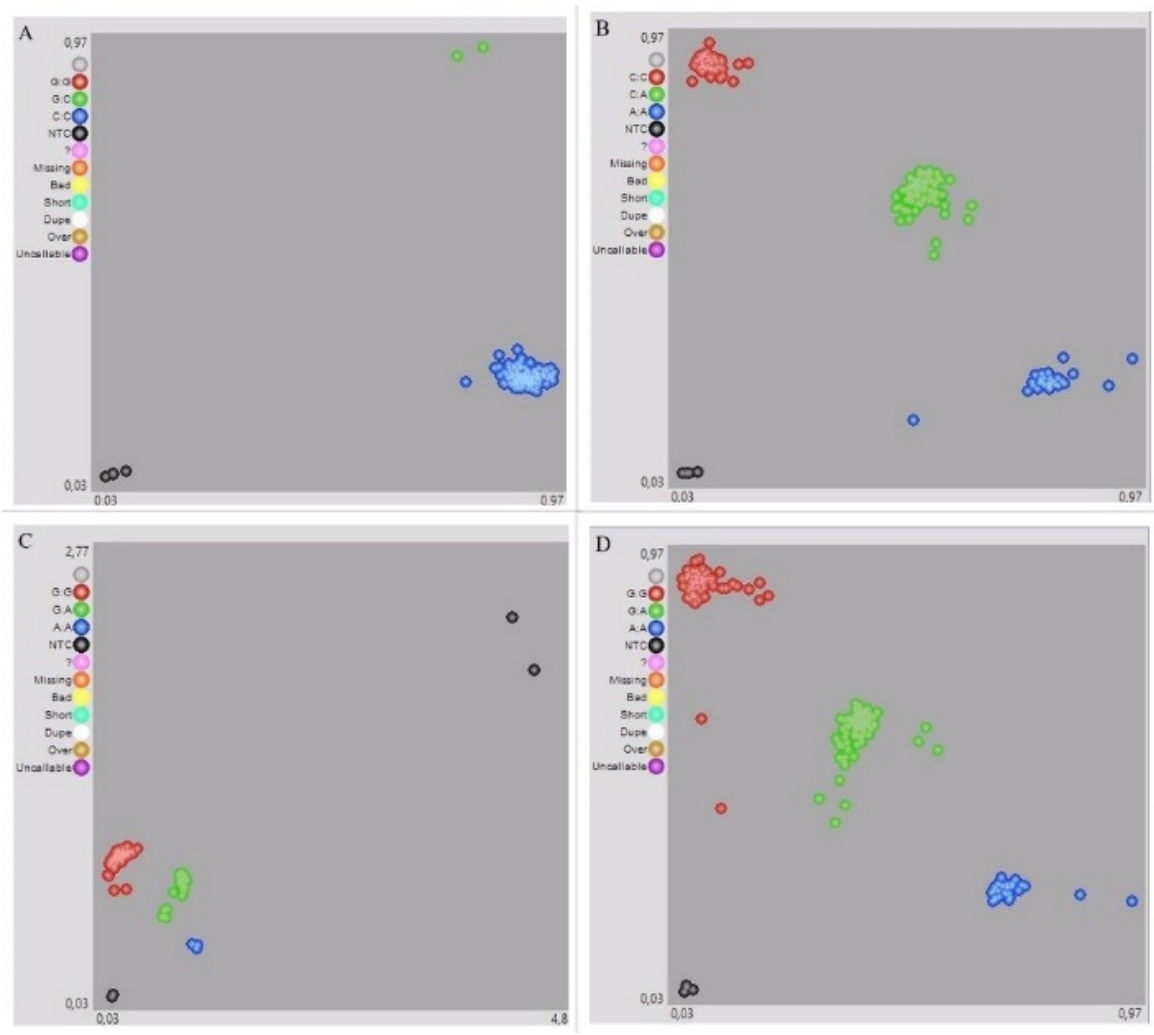
A negative control was added to the final wells.